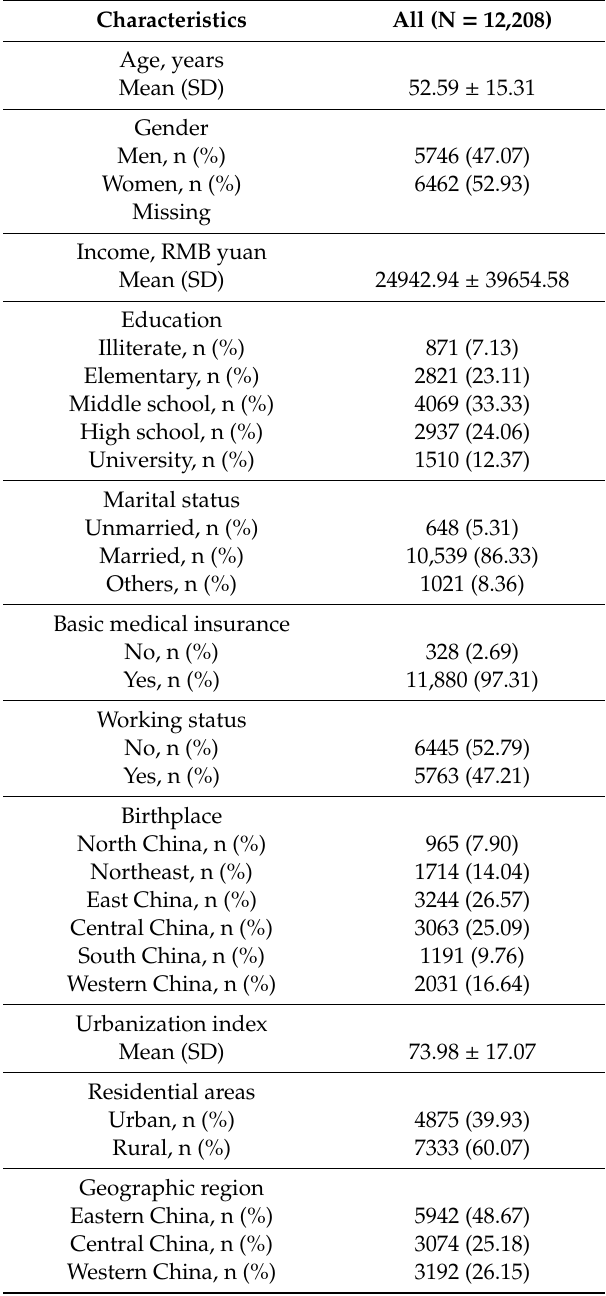
Table 1. Characteristics of